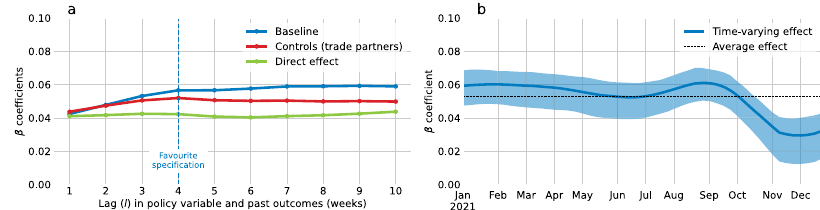
Fig. 8 Robustness checks for varying lags and time-varying impact of vaccination. a Main regression coef fi cients for various lag values. b Time-varying estimate of the impact of vaccination on economic activity. The blue shaded area is the 95% con fi dence interval obtained from 100 bootstrap samples and centred around the main estimate (blue). The black dashed line indicates the average effect across